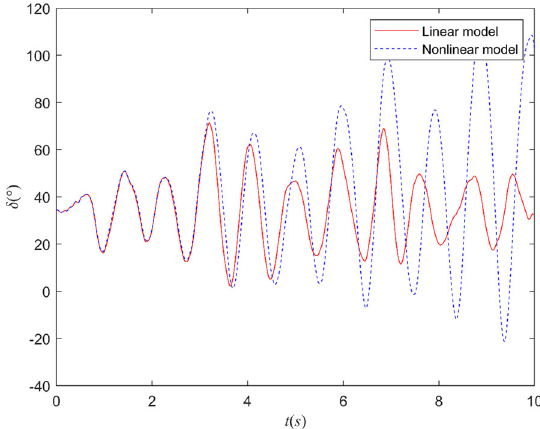
Fig. 10 Comparison of power angle curves between linear and nonlinear models of the system ( σ = 0.8)